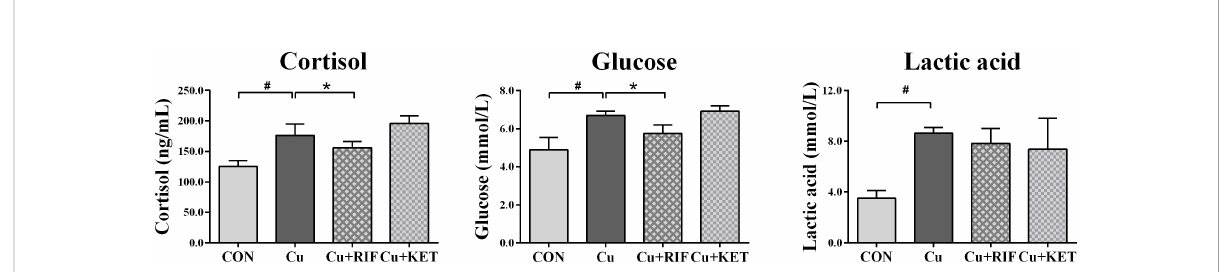
FIGURE 1 Plasma stress indicators in largemouth bass subjected to RIF or KET under Cu exposure (n = 6). Signi fi cant differences between CON and Cu groups, Cu and Cu+RIF groups, as well as Cu and Cu+KET groups were indicated by “ # ” , “ * ” , and “ + ” ( P <